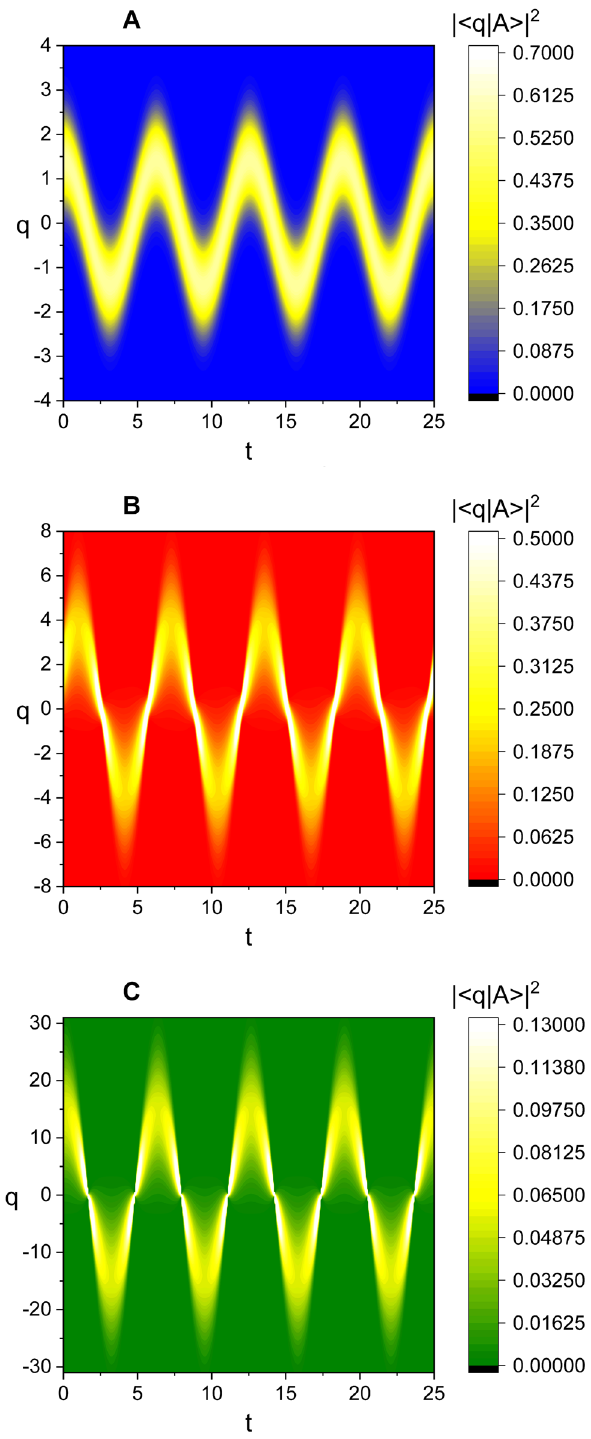
2 where ( c q A Figure 1. Time evolution of the probability density 1 , c 2 ) are (1, 1) for A, (5, 2) for B, and (1, |� | �| 100) for C. The measure of nonstaticity is 0.00 for A, 2.37 for B, and 35.70 for C. We have used ω (cid:31) θ 0 , and ϕ 1 , ǫ 1 , t 0 0 . We see from Eq. (5) that the allowed values of c 3 , when c 1 and c 2 have been = = = = = determined, are two: One is positive and the other is negative. Among them, we choose a positive one as the value of c 3 in this and all subsequent figures for